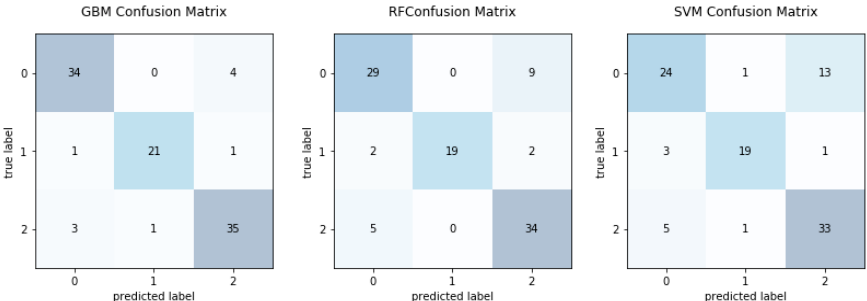
Figure 5. Confusion matrices comparing the results of gradient boosting machine, random forest and support vector machine with grid search optimizer on {FN}-{OZ}-{S} classification.